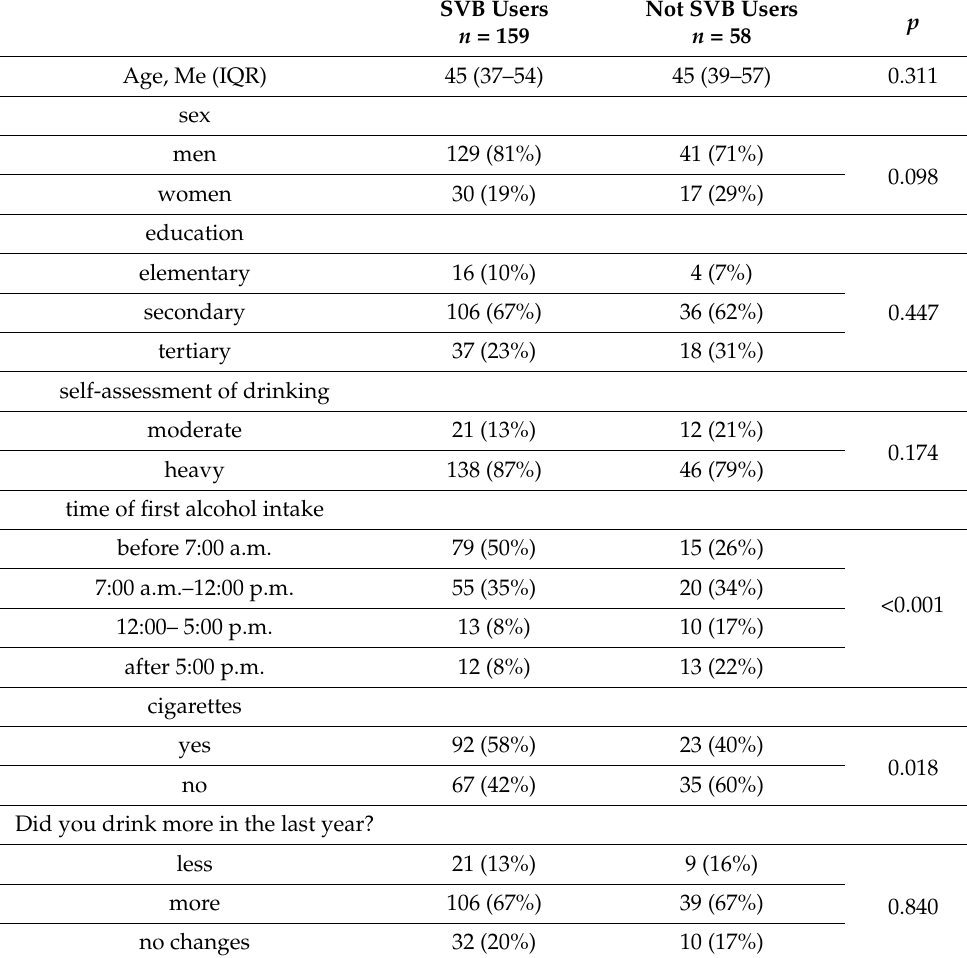
Table 1. Characteristics of respondents and their drinking habits.